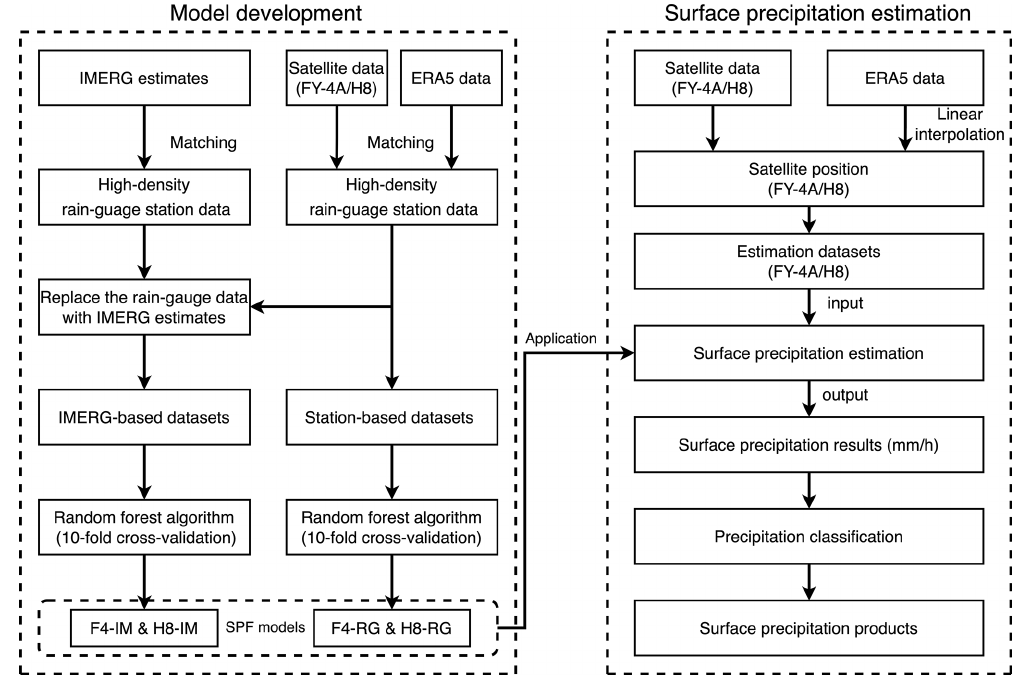
Figure 2. Flowchart of the surface precipitation integration algorithm.